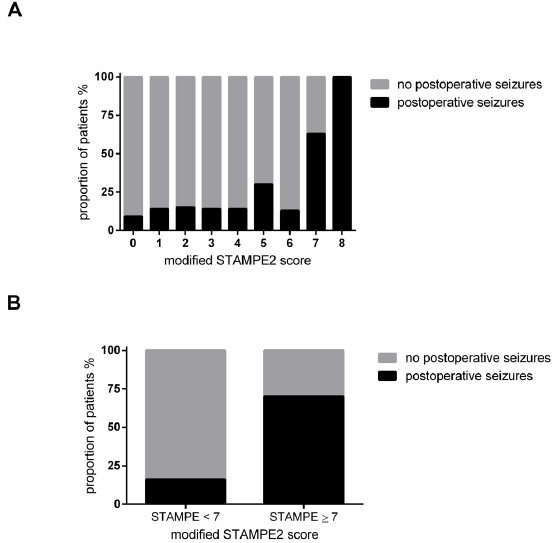
Figure 3. ( A ) Relative occurrence of postoperative seizures in the total cohort in relation to the modified STAMPE2 score. ( B ) Comparison of the occurrence of postoperative seizures for patients with a modified STAMPE2 score of seven points or more as compared with lower scores, Pearson: p < 0.001: The left column (modified STAMPE2 < 7) represents 97.3% of all patients, 57 patients with and 304 patients without seizures, the right column represents the remaining 2.7% of all patients, seven patients with seizures and three patients without seizures.